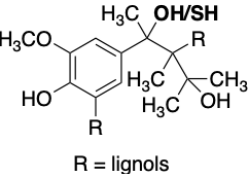
Figure 5. Example of the chemical structure of a lignin monomer known as a lignol. The commercial lignin material used in this work has a thiol group in the benzylic position instead of an alcohol group (highlighted in